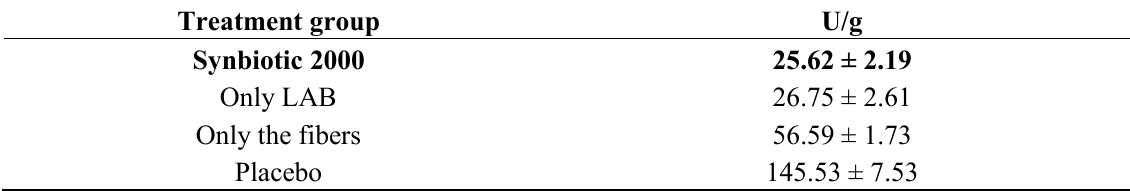
Table 2. Myeloperoxidase (MPO) activity in the supernatant presented as U/g lung tissue, after treatment with Synbiotic 2000, only the LAB in Synbiotic 2000, only the fibers in Synbiotic 2000 and placebo, respectively [71]; p <